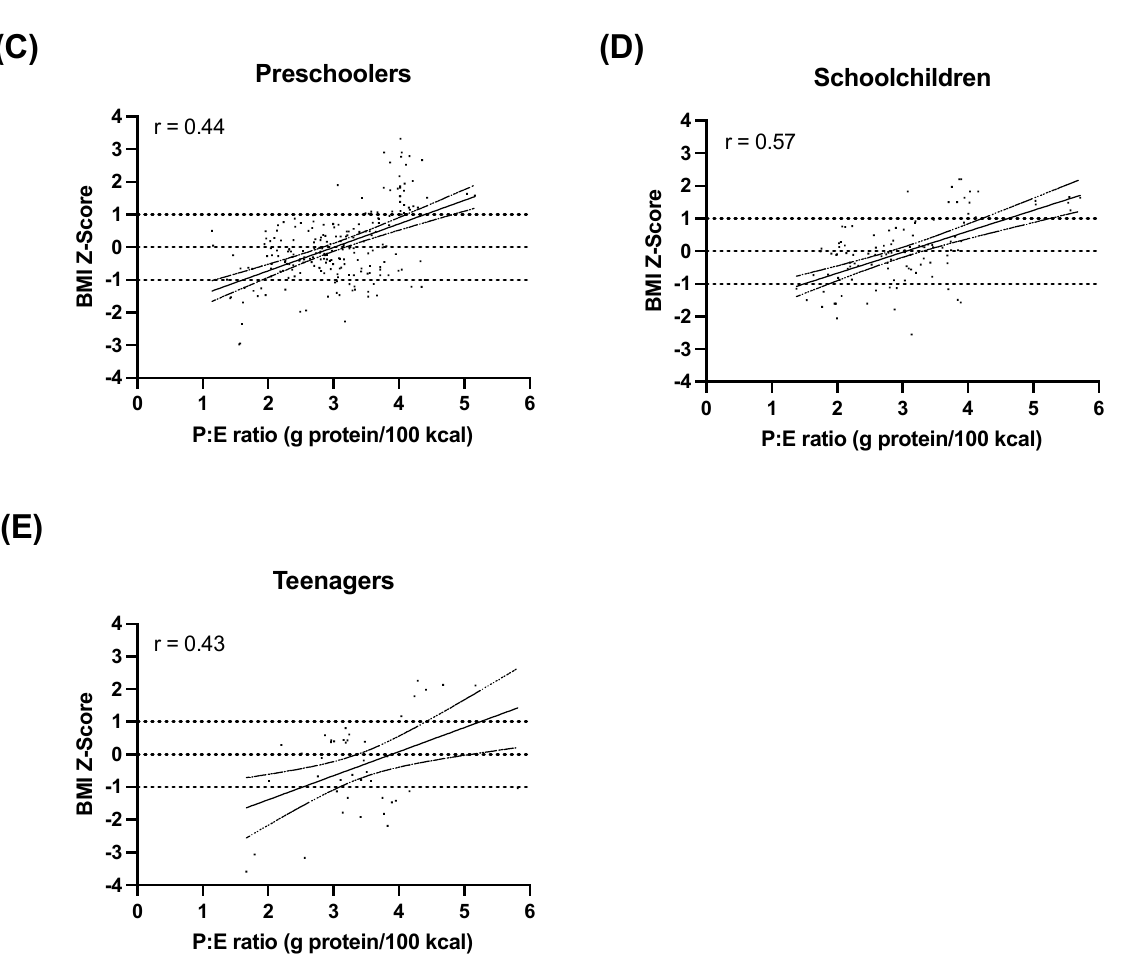
Figure 6. Pearson’s correlation between P:E ratio and BMI Z-Score in PKU patients classified by age group. P:E ratio was calculated from patients’ dietary recalls and is expressed as protein per 100 kcal. BMI Z-Score was calculated from anthropometric measurements (weight, height). Eutrophic state (BMI Z-Score between − 1 and 1) is indicated in dotted lines. ( A ) Correlation between the BMI Z-Score and the P:E ratio in all etary groups. ( B ) Correlation between the BMI Z-Score and the P:E ratio in infants (<2years). ( C ) Correlation between the BMI Z-Score and the P:E ratio in preschoolers (2 years to <6 years). ( D ) Correlation between the BMI Z-Score and the P:E ratio in schoolchildren (6 to <11 years). ( E ) Correlation between the BMI Z-Score and the P:E ratio in teenagers (11 to 18